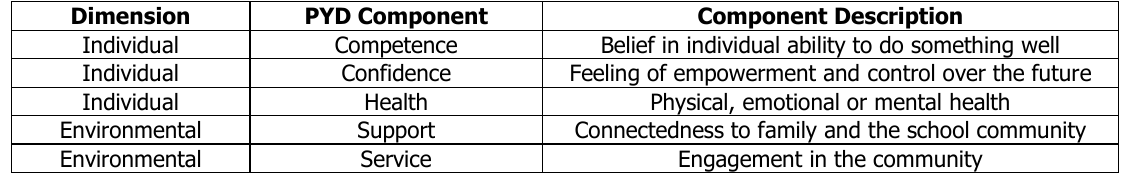
Conceptual framework for developing PYD measurement